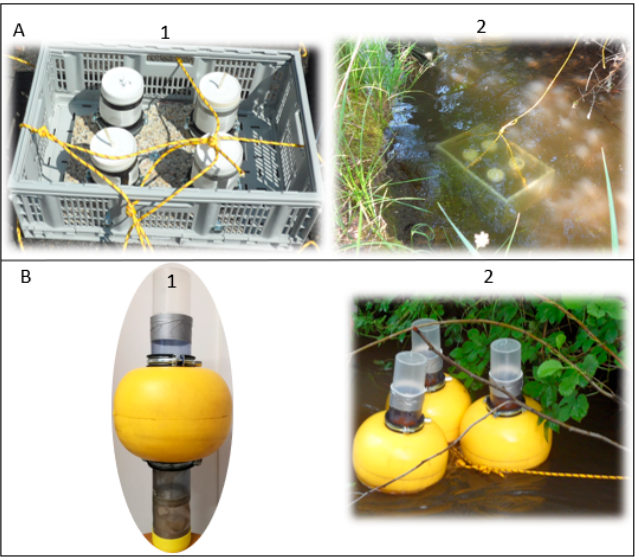
Figure 2. Photographs of active biomonitoring devices dedicated to in situ exposure of Chironomus riparius larvae. ( A ): submerged cages dedicated to the assessment of growth, survival and bioaccu- mulation; ( B ): Floating cages dedicated to the monitoring of emergence; 1: before deployment and 2: installed